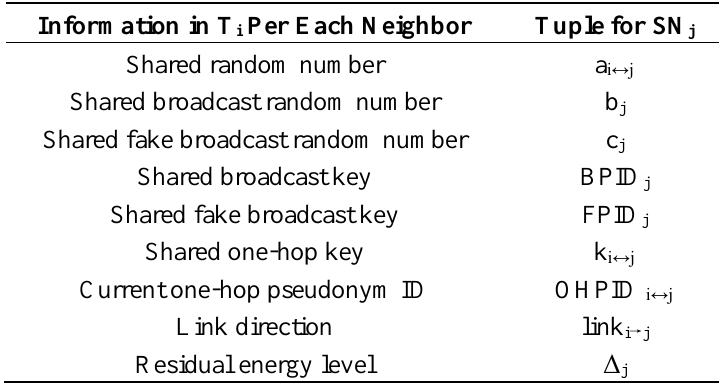
Table 3. Shared values among sensor neighbors. If SN i has N i neighbors, then T i will have N i